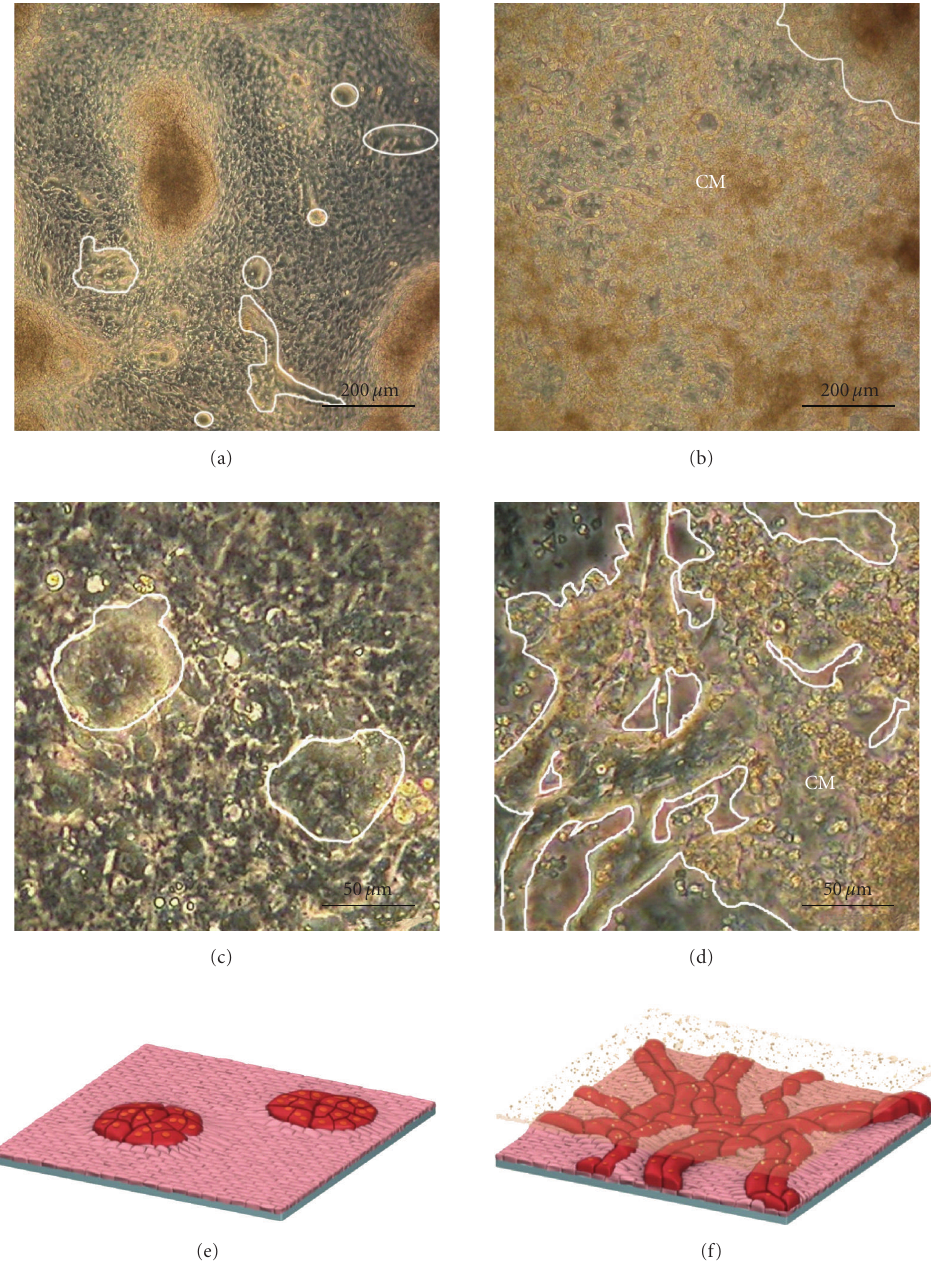
Figure 1: Phase-contrast micrographs in typical view of beating cardiomyocytes (CM; enclosed with a white line) di ff erentiated from P19CL6 cells by the basal protocol ((a) and (c)), and P19CL6-A1 cells by the developed protocol ((b) and (d)) on day 16. Cardiomyocytes in (b) form the large cluster that extends beyond the visual field while those in (a) form the small clusters. The clusters of cardiomyocytes in (c) are small and round in a single cell layer region. They are composed of small-sized beating cells densely arranged. On the other hand, the cluster in (d) is large and forms a mesh-like sheet structure in multicell layers. It is composed of elongated cardiomyocytes. (e) and (f) are diagrams of (c) and (d), respectively, in which cardiomyocytes are depicted in Indian